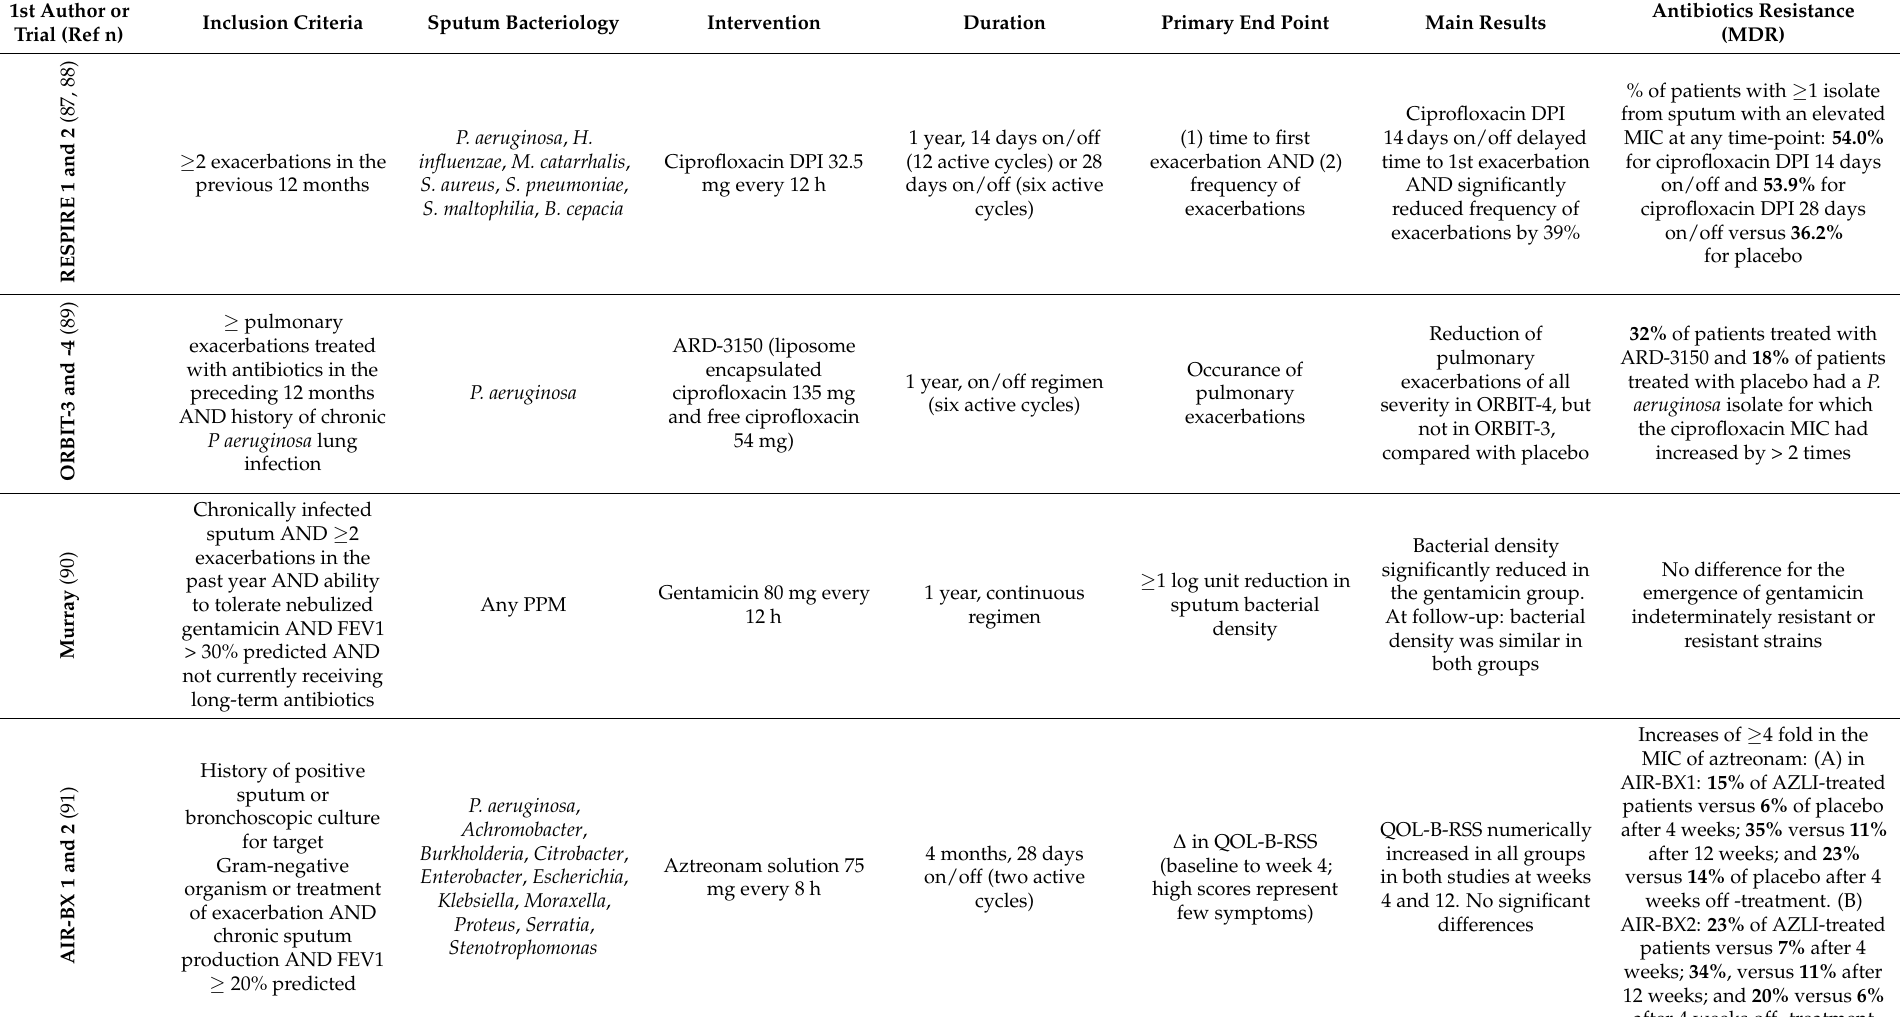
Table 5. Trials with long-term inhaled antibiotics in